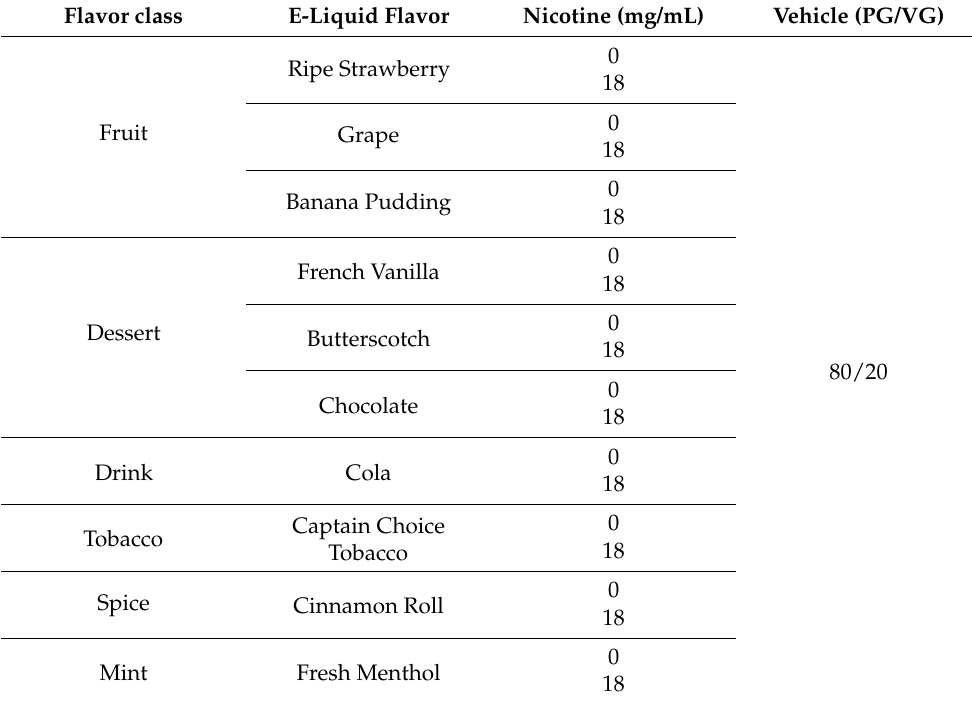
Table 1. Composition of the different flavored e-liquids used in this study. Flavor